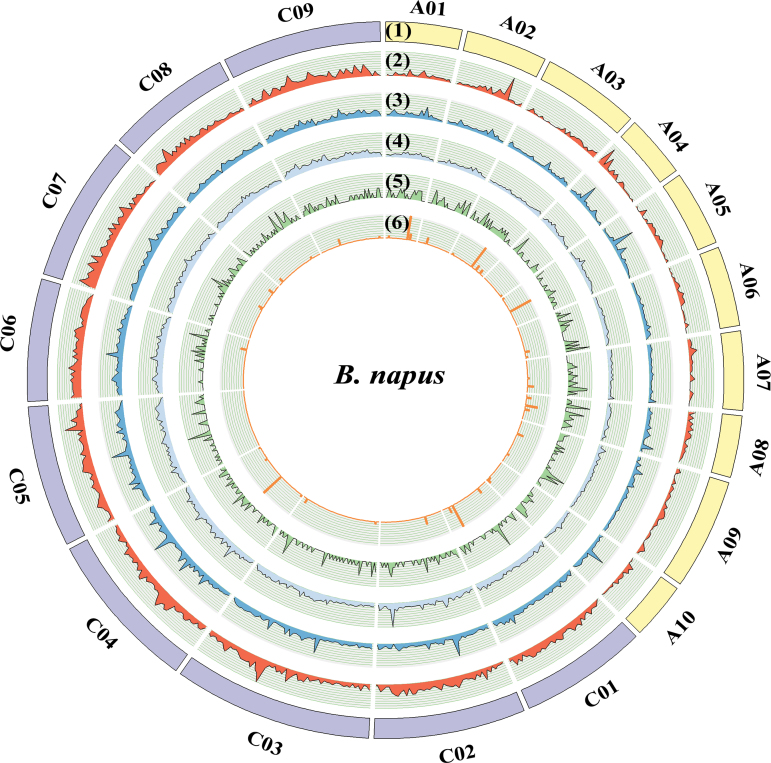
Genomic distribution of miRNAs in B. napus. From outer to inter circles: (1) chromosomes of B. napus; (2) LTR retrotransposon; (3) small RNA reads; (4) 24 nt small RNA reads; (5) miRNAs identified by this study; (6) small RNA reads that can be mapped to the mature sequences of miRNAs. The peak value represents the density of each element with a window of 1Mb in the B. napus genome.